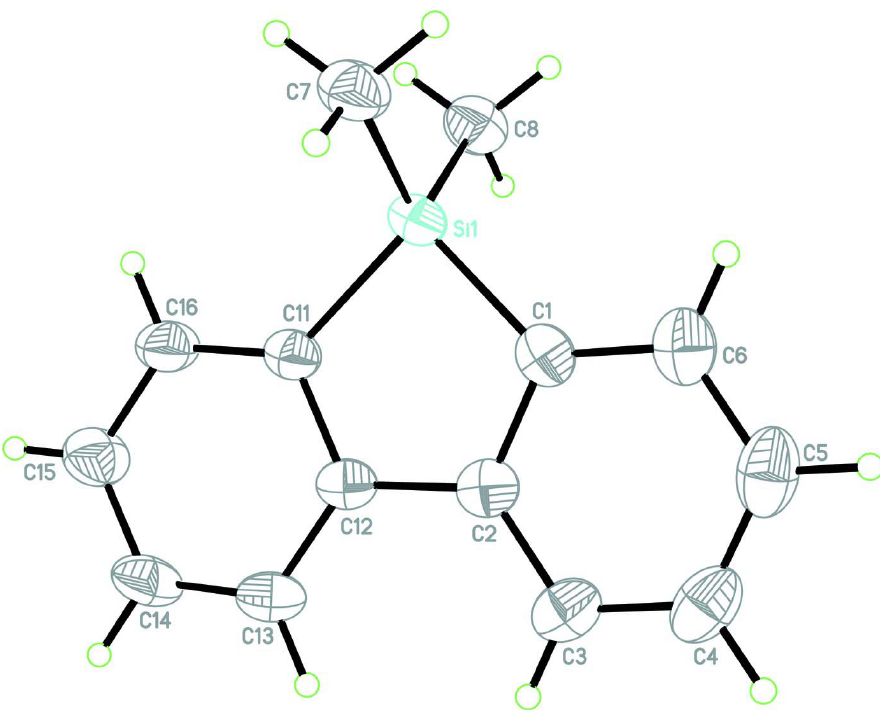
Figure 1 Perspective view of the first molecule in the asymmetric unit of the title compound with the atom numbering scheme; displacement ellipsoids are at the 50% probability level; H atoms are drawn as small spheres of arbitrary